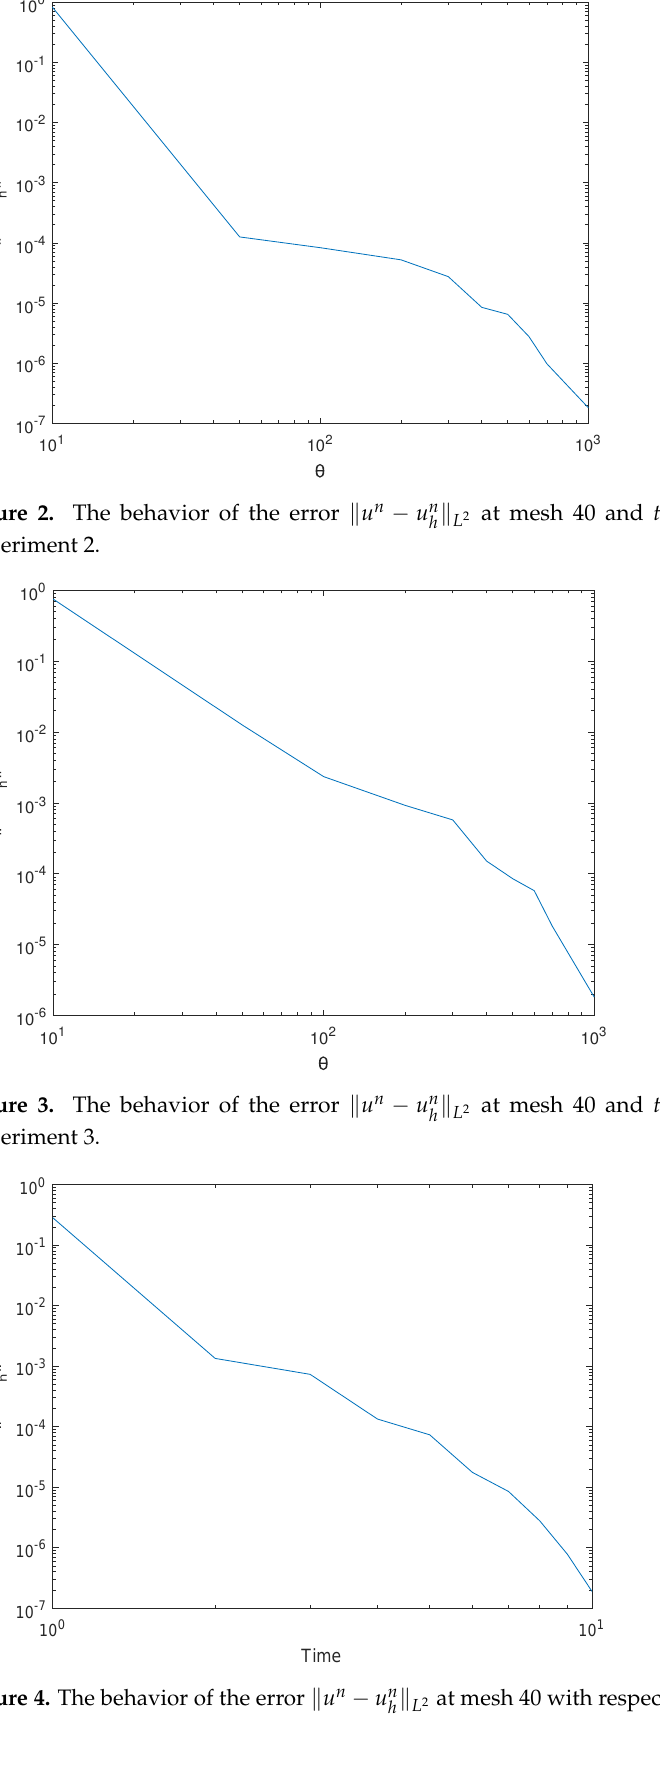
Figure 4. The behavior of the error (cid:107) u n − u n